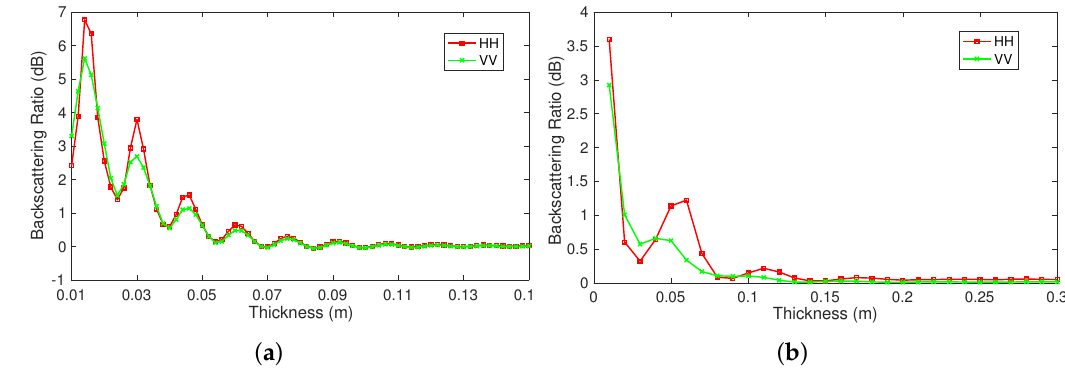
Figure 10. Backscattering ratio of HH and VV polarizations with respect to the thickness of the newly formed sea ice at an incidence angle of 40 ◦ for ( a ) C-band and ( b ) L-band. The backscattering ratio was defined to describe the scattering difference between smooth and rough ice–water